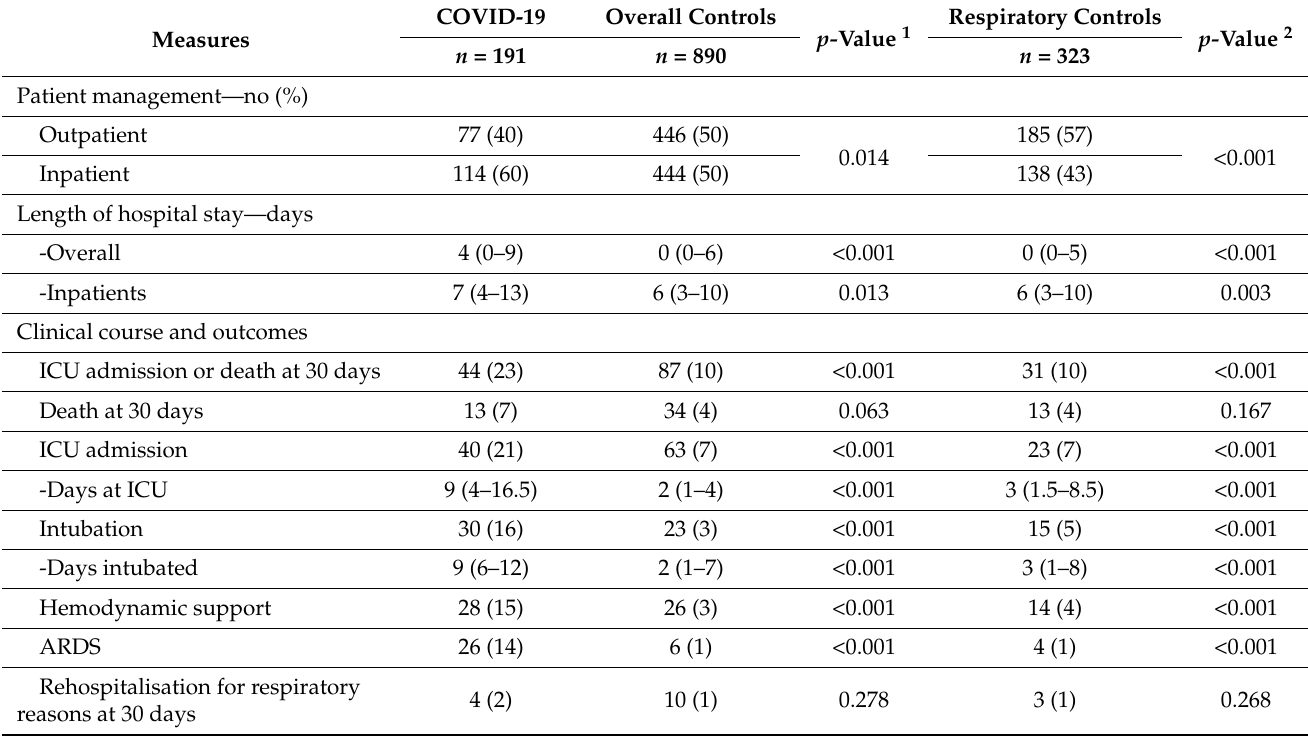
Table 2. Patient management and outcomes in COVID-19 and